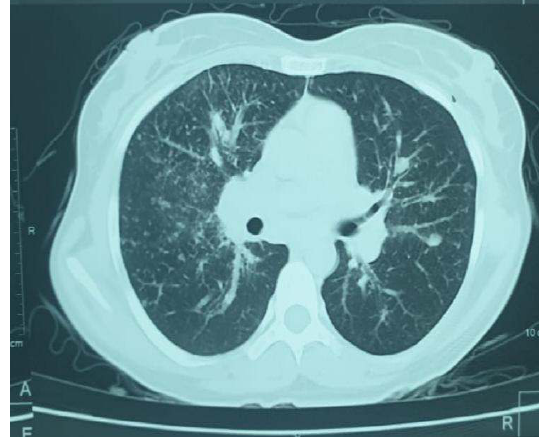
Figure 2: CECT Thorax: paralymphatic nodules